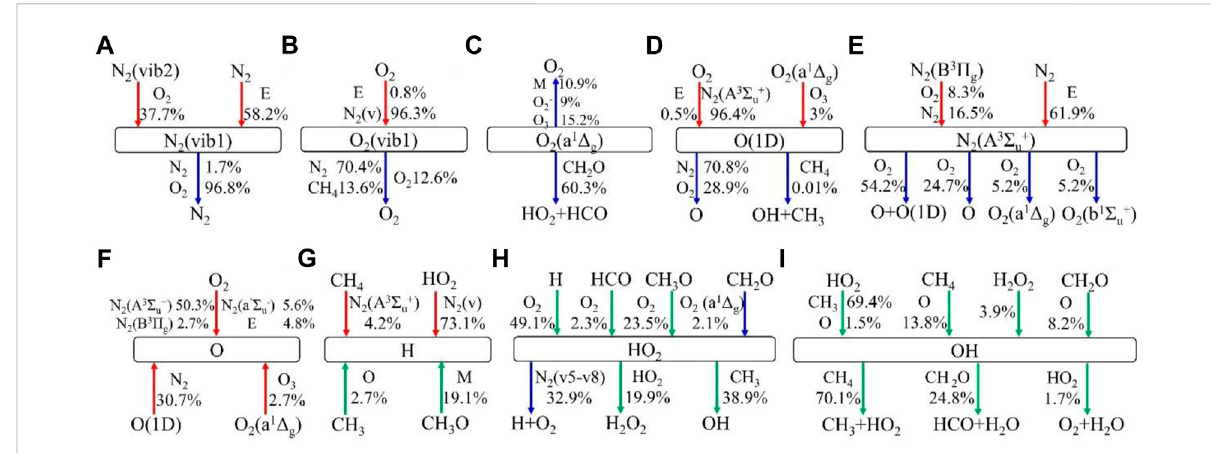
FIGURE 10 Path fl uxes of production and consumption of (A) N 2 (vib1), (B) O 2 (vib1), (C) O 2 (a 1 Δ g ), (D) O(1D), (E) N 2 (A 3 Σ u + ), (F) O, (G) H, (H) HO 2, and (I) OH at the end of discharge for case 2. The red lines are plasma excitation reactions, blue lines are plasma quenching reactions, and green lines are combustion reactions. For one sub fi gure, all percentages do not sum to 1 exactly due to some minor proportions in other